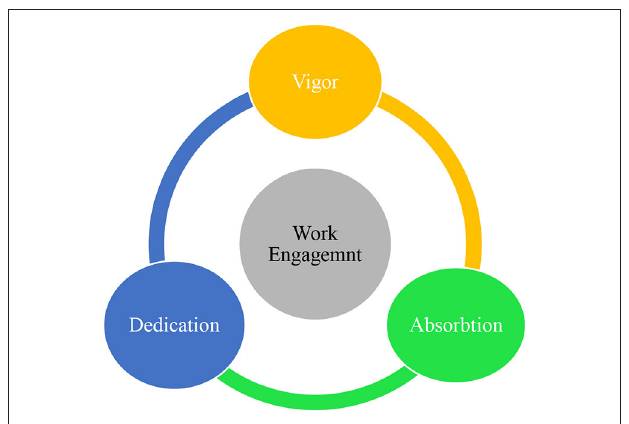
FIGURE 2 | The dimensions of work engagement (Schaufeli et al.,